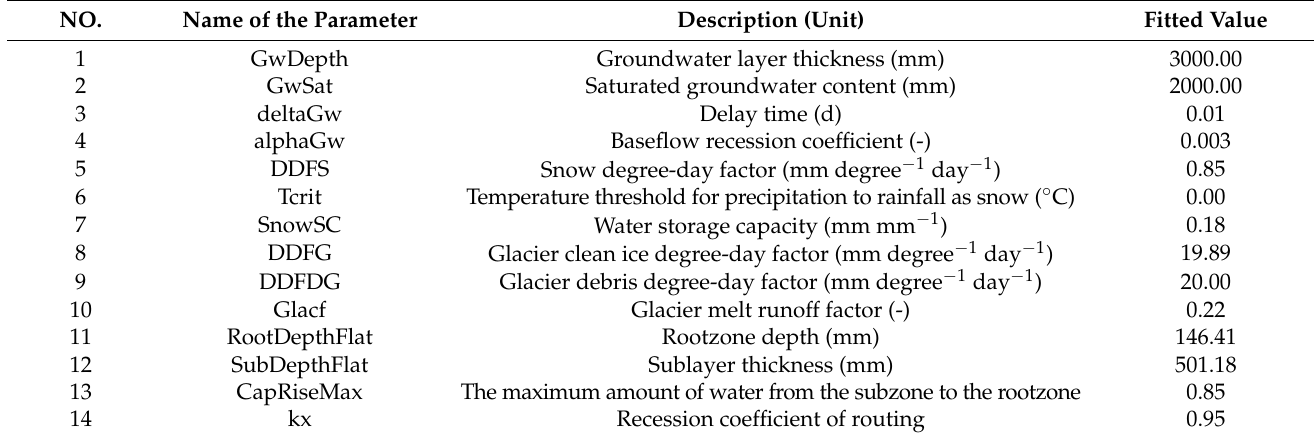
Table 3. Calibrated SPHY model parameter values used for the